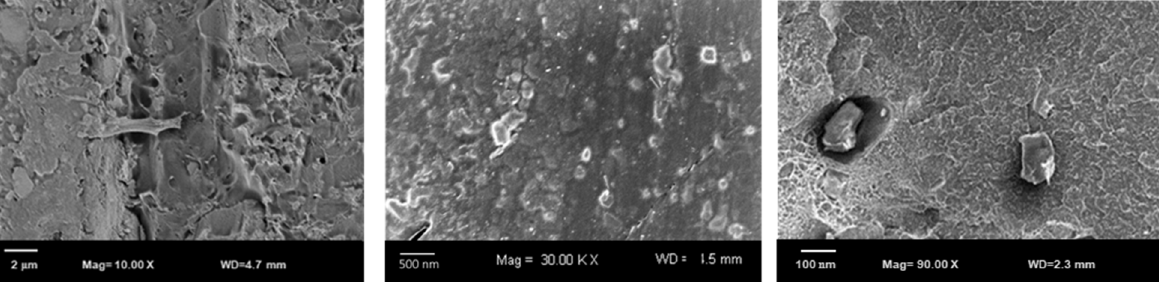
Figure 6. SEM cross-sectional images of PLA composites reinforced with 1.5% CNC and 1.5% nano-zinc oxide at different magnifications showing irregular distribution of zinc oxide particles.